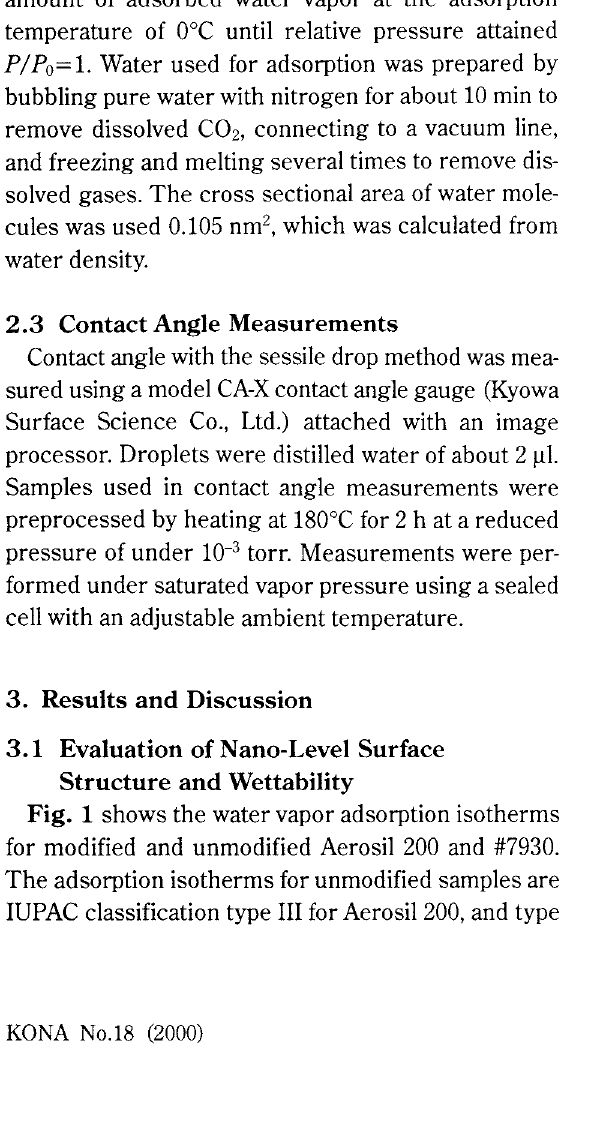
Fig. 1 H 2 0 Adsorption Isotherms of Unmodified and Modified Silicas 0 Unmodified Aerosil 200 e 41% modified Aerosil 200 0 Unmodified Corning #7930 + 21% modified Corning #7930 .A. 40% modified Corning